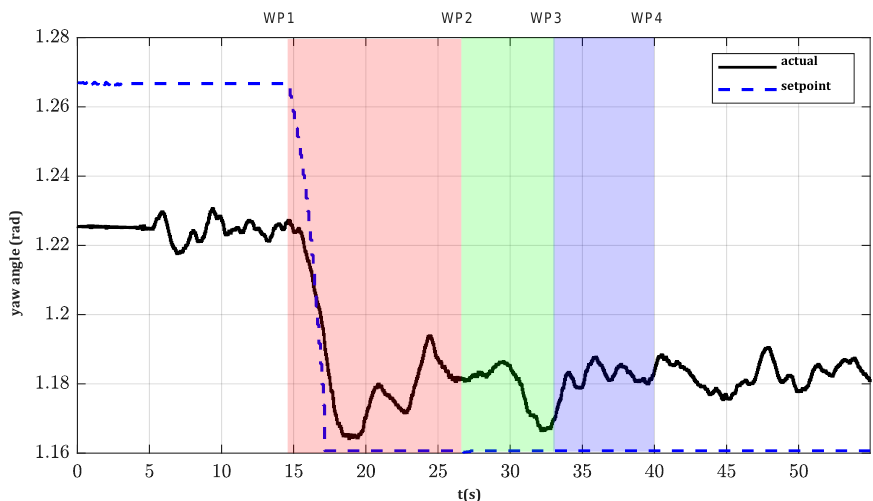
Figure 13. The pitch angle of the UAV in clip installation.